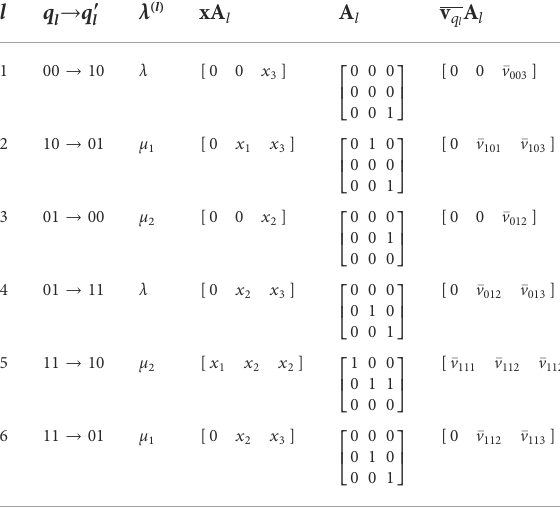
TABLE 1 Table of transitions for the Markov chain in Figure